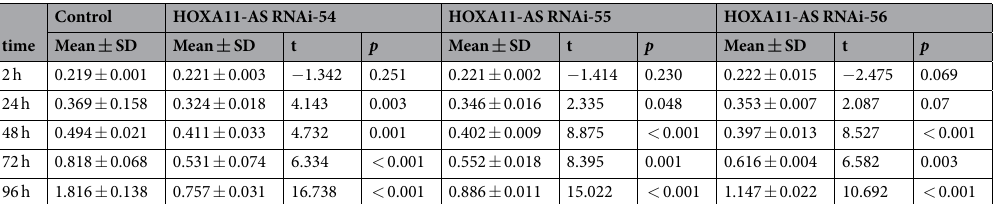
Table 2. Effect of HOXA11-AS RNAi on proliferation of NSCLC A549 cell line, determined by CCK-8 assay. t values were obtained by comparison with the negative control.